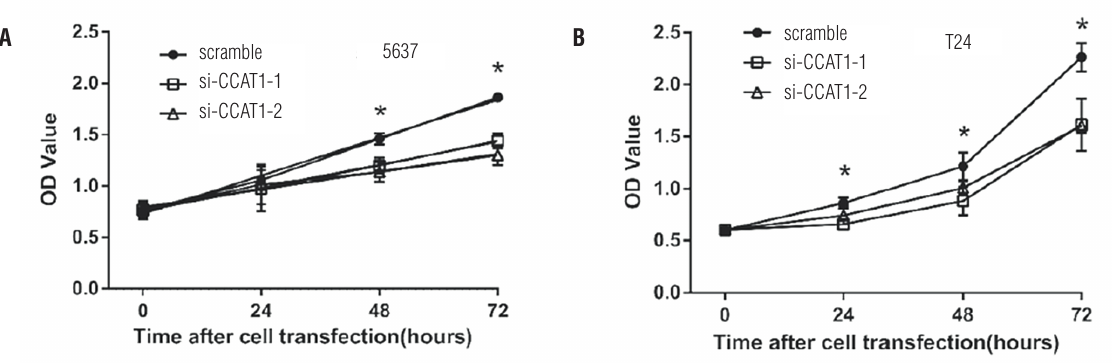
Data are represented as mean ± SD. *Indicates P <